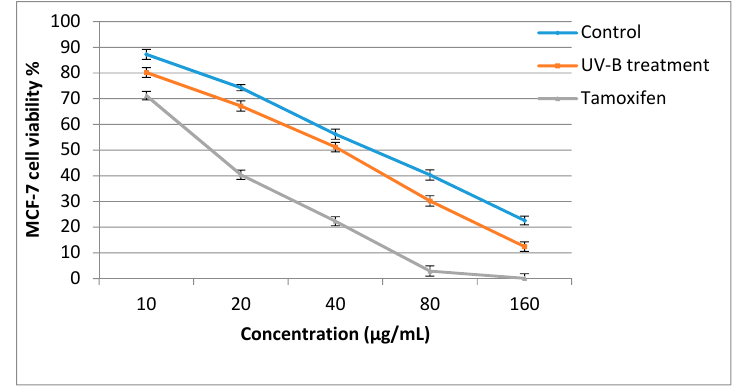
Figure 3 . Effect of sweet basil non-treated leaves and UV-B treated (3.60 W/m 2 , 8-h) leaves against breast cancer cell line (MCF-7) viability. Bars represent standard errors of the means.